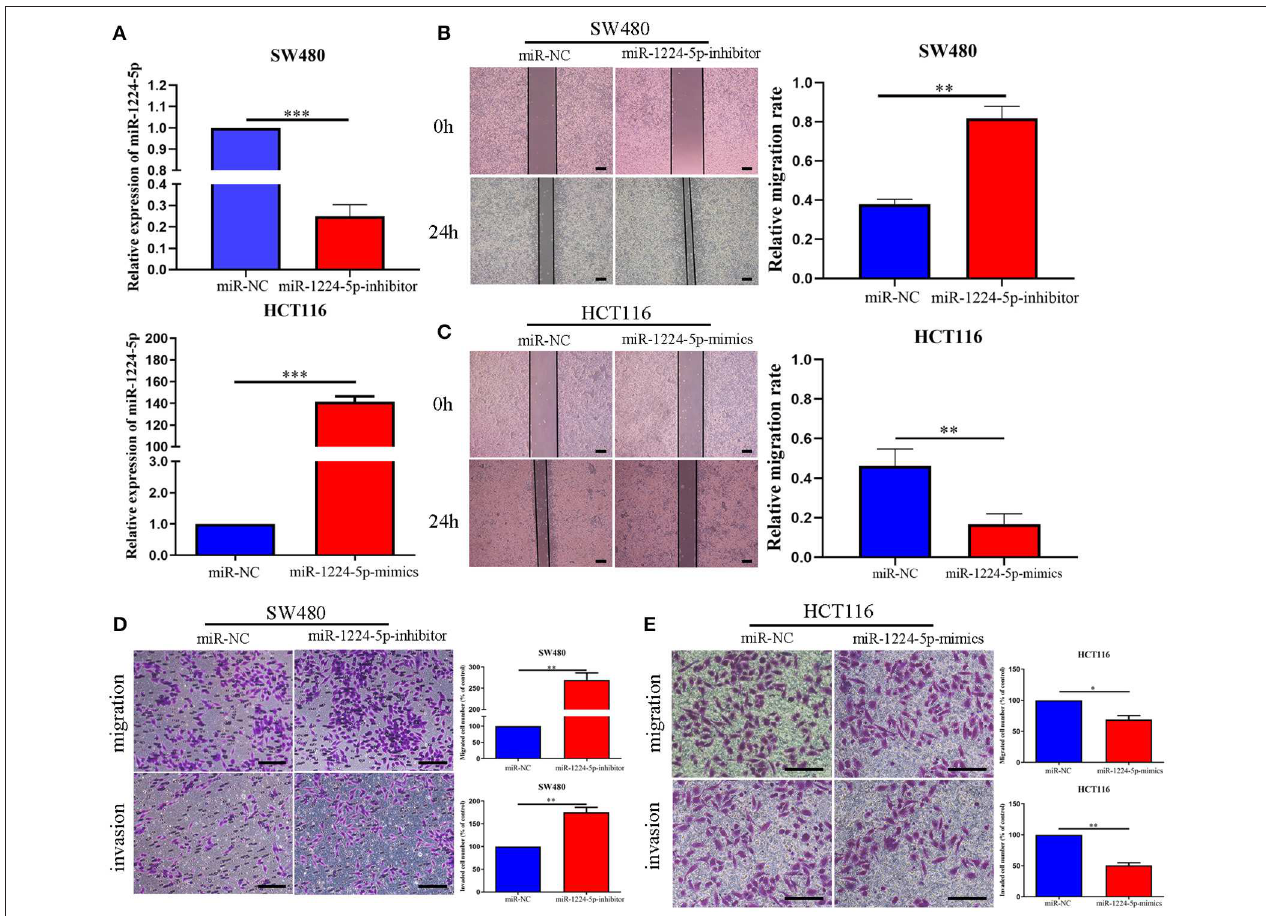
FIGURE 2 | miR-1224-5p inhibits the migration and invasion of CRC cells in vitro . (A) SW480 and HCT116 cells that were transfected with miR-1224-5p-inhibitor and miR-1224-5p-mimics lentivirus were subjected to qRT-PCR for miR-1224-5p. (B,C) Effects of miR-1224-5p on migration in CRC cell lines were detected by wound healing assay, scale bars: 300 µ m. (D). Cell migration and invasion as measured by Transwell assays were promoted by miR-1224-5p knockdown in SW480 cells, scale bars: 100 µ m. (E) miR-1224-5p overexpression inhibited migration and invasion of HCT116 cells, scale bars: 50 µ m. Data represent the mean ± SD from three independent experiments. Student’s t -test was used to determine statistical significance: * p < 0.05, ** p < 0.01, and *** p <